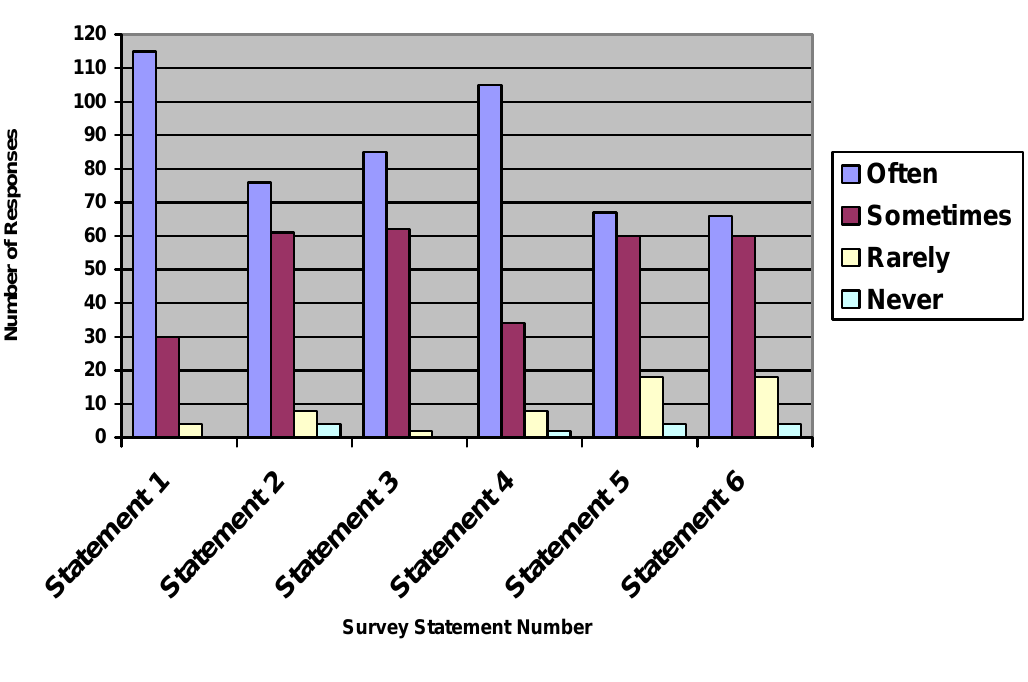
Figure 16. Student Survey given after implementation of posting and communicating daily learning